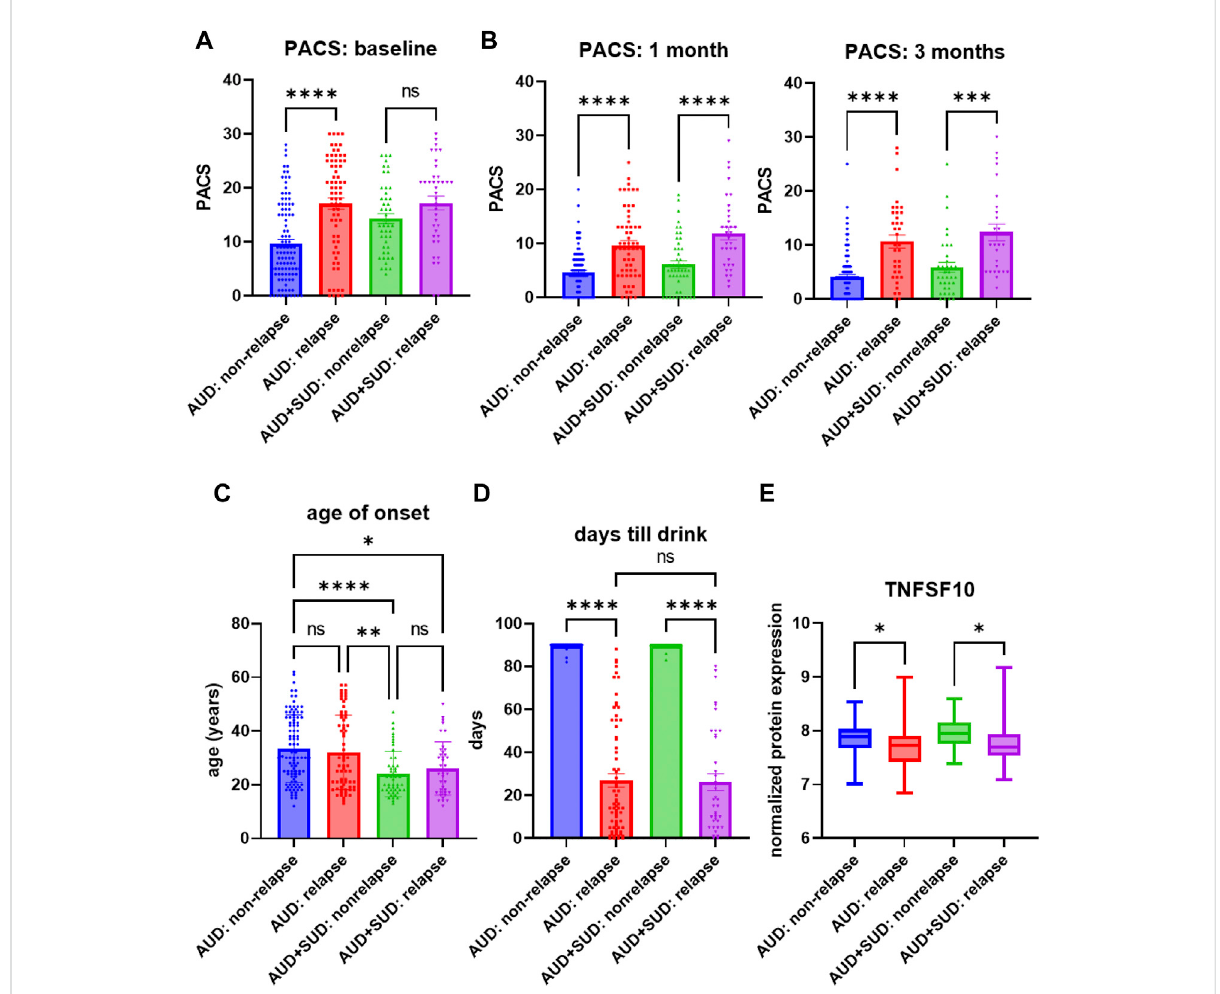
FIGURE 3 Craving intensity and acamprosate treatment. (A) Baseline PACS was associated with acamprosate treatment response only in patients with alcohol use disorder but not AUD patients with ahistory ofother substance use disorders(SUD),( F (3,252 ) =15.76, p < 0.0001). Relapse was de fi ned as takingonedrinkduring3 monthsofacamprosatetreatment,whilenon-relapsewasde fi nedasremainingabstinentduring3 monthsofacamprosate treatment. (B) Higher PASC was observed in the relapse groups after acamprosate treatment for 1 month, ( F (3, 232 ) = 20.85, p < 0.0001), and 3 months,( F (3,186) =19.62, p < 0.0001). (C) AgeofonsetforAUDwassigni fi cantlylowerinAUDsubjectswithhistoryofotherSUD( F (3,251 ) =8.808, p < 0.0001). (D) The number of days until fi rst alcohol use during the 3 months of acamprosate treatment was similar between AUD patients with and without a history of SUD, ( F (3, 254 ) = 303.7, p < 0.0001). (E) Lower baseline plasma TNFSF10 level was observed in the relapse groups regardless of a history of other SUD, ( F (3, 232 ) = 6.376, p < 0.0001). **** p < 0.0001, *** p < 0.001, ** p < 0.005, * p <